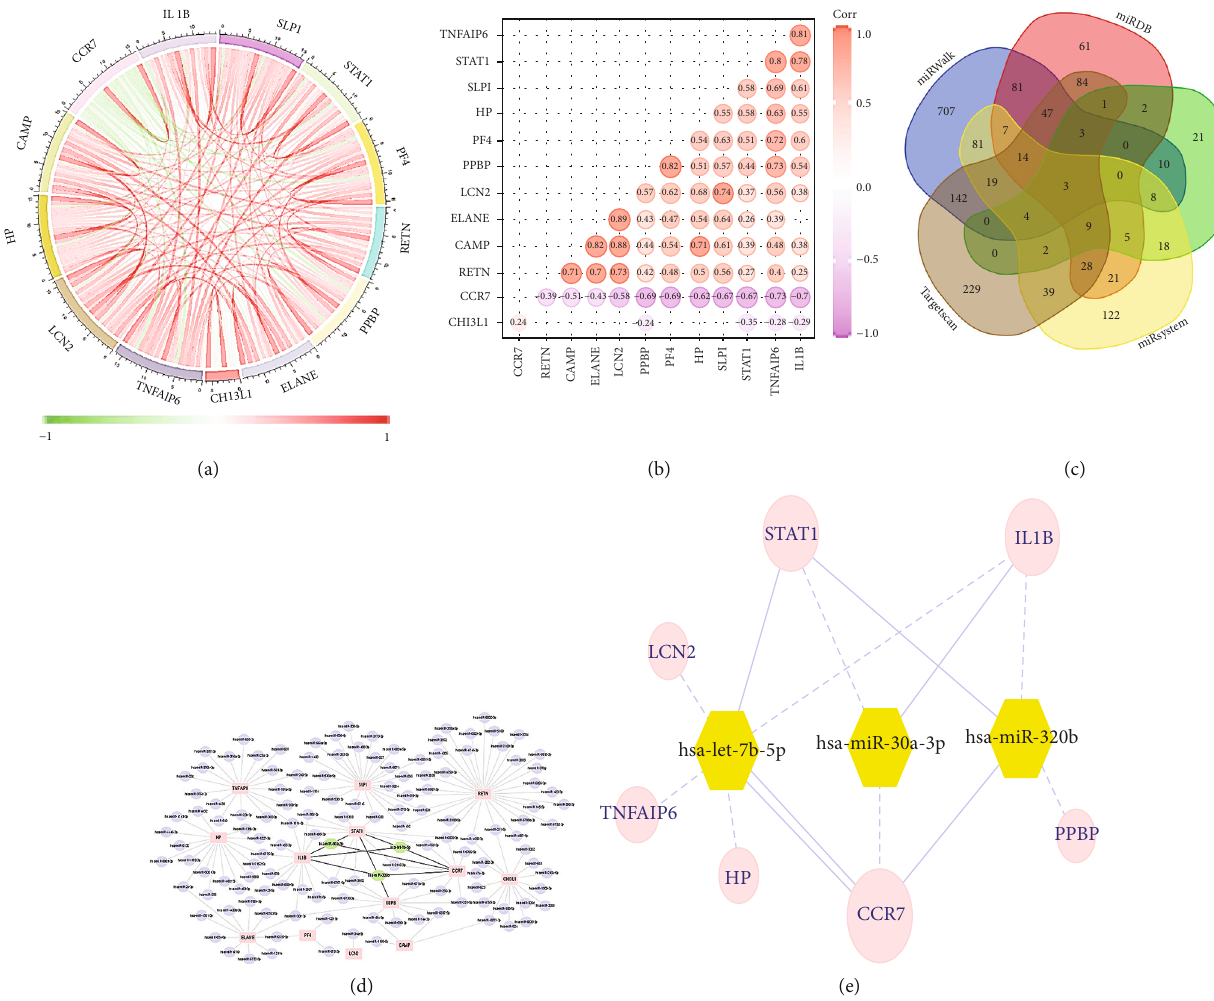
Figure 5: Explore key genes and predict miRNA. (a, b) Correlation analysis of 13 key genes. (c) Venn diagram fi lter miRNA. (d, e) miRNA and gene